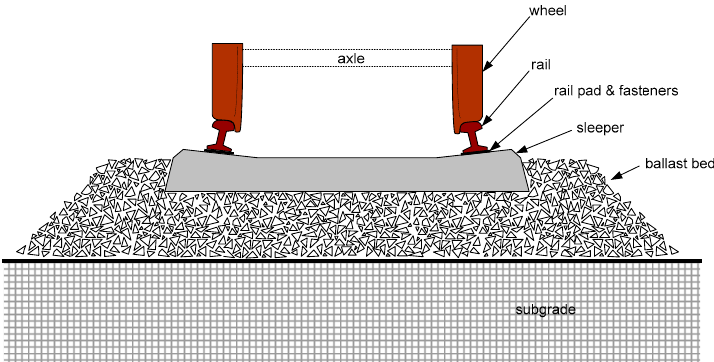
Figure 25. Typical structure of ballast track [42].